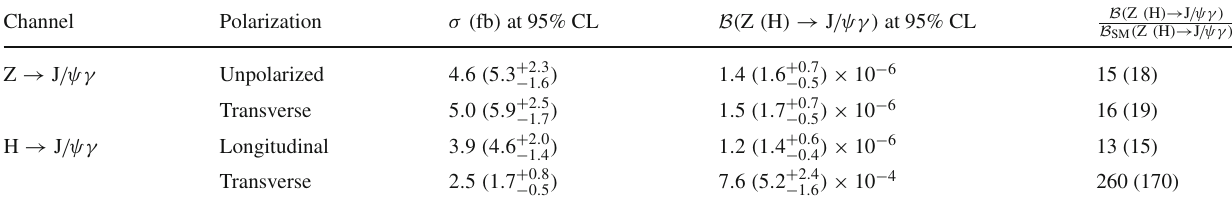
Table 3 Limits for Z and H decays to J /ψ − > μμ final states. Shown in the second and third columns are the observed and expected limits for cross sections and branching fractions, with the upper and lower bounds in the expected 68% CL intervals shown, respectively, as super-